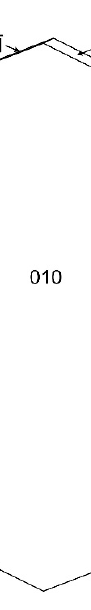
Figure 1. Chenowethite blades on cotype specimen #76260 from the Blue Lizard mine. The field of view is 0.84 mm across.